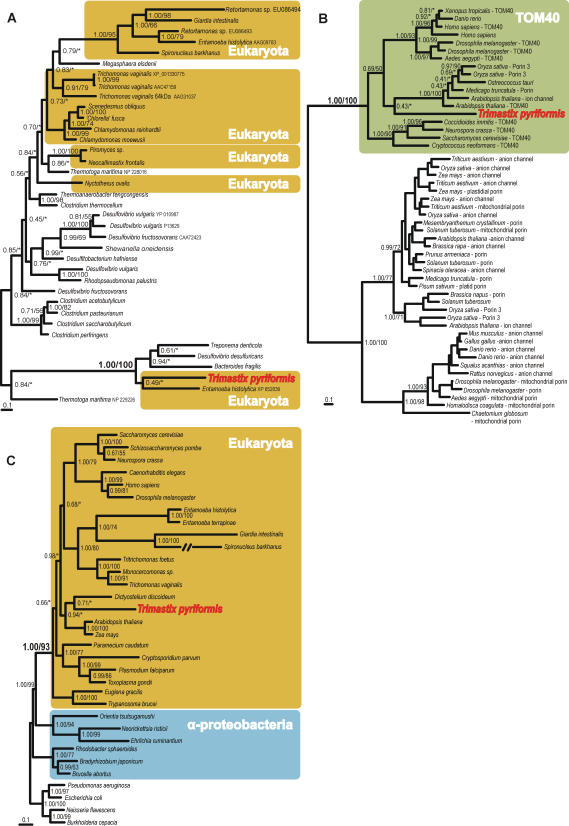
Phylogenetic trees of (A) [FeFe] hydrogenase, (B) TOM40 and (C) cpn60.Trees were constructed using MrBayes. Numbers on the branches represent statistical support expressed in Bayesian posterior probabilities/maximum likelihood bootstrap support computed with RAxML. Asterisks (*) indicate a bootstrap value of <50%. In (B) brief names of the proteins annotated according to GenBank nomenclature follow the taxon names. The statistical support for non-relevant nodes was not included for simplicity.